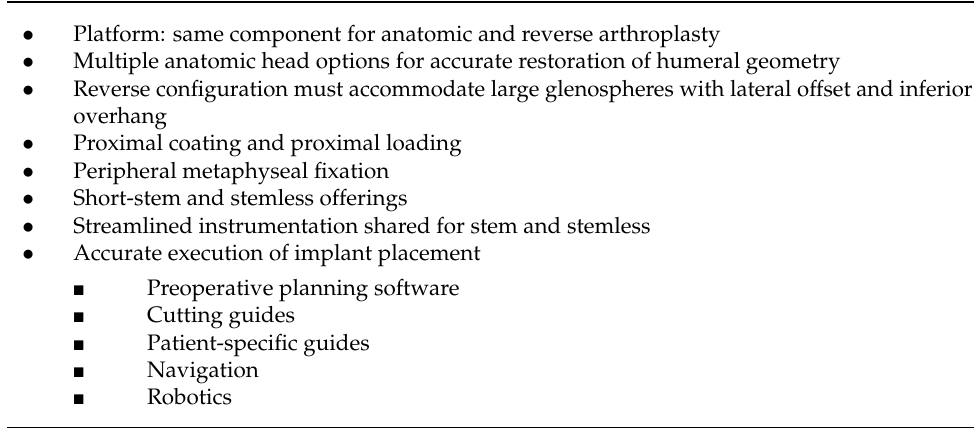
Table 1. Desirable features for contemporary humeral component